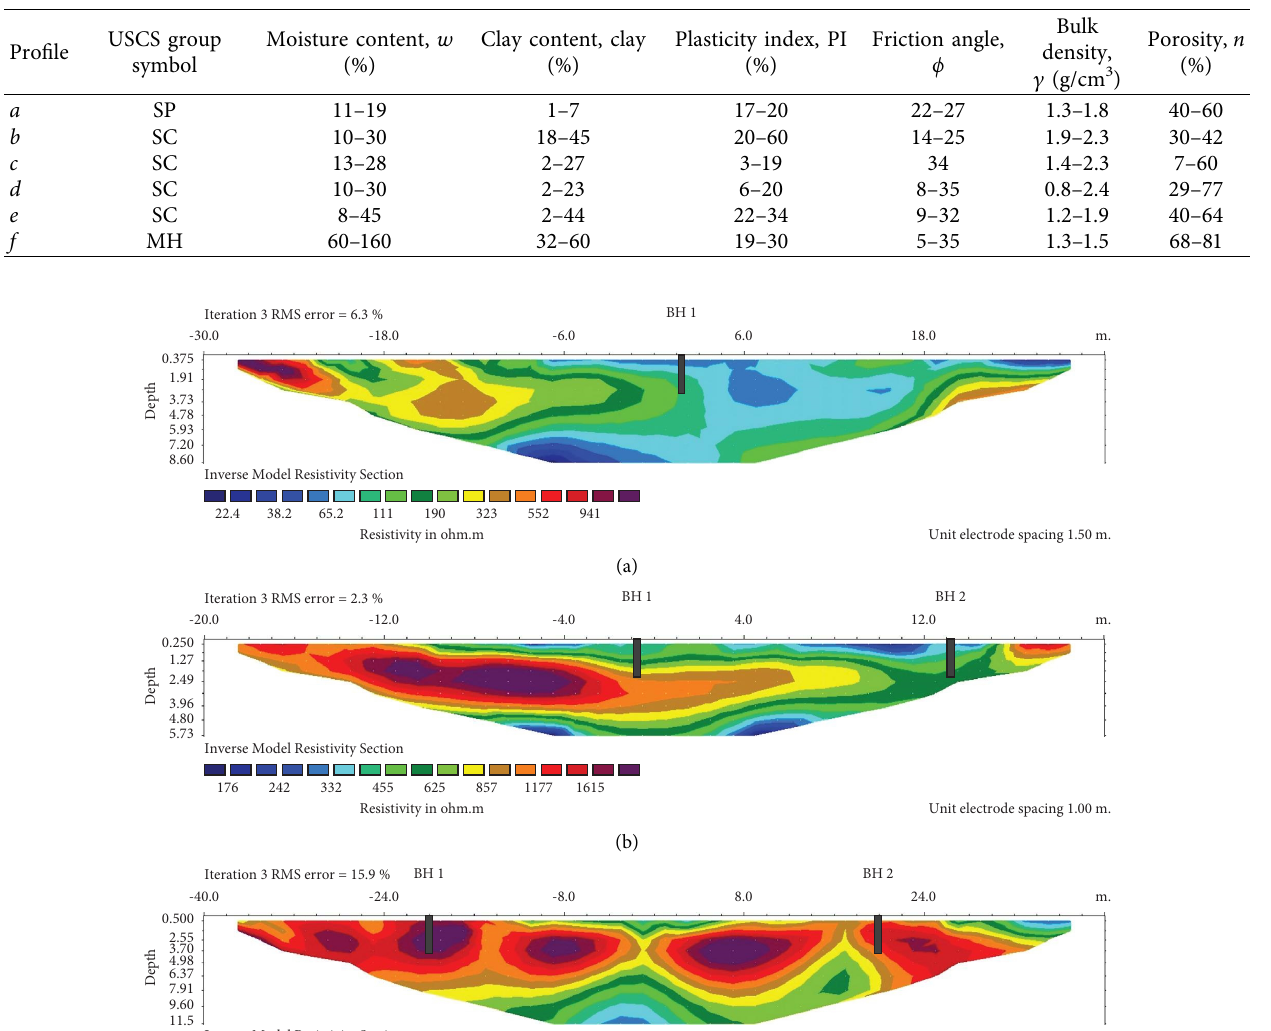
Table 1: Range value of study soil